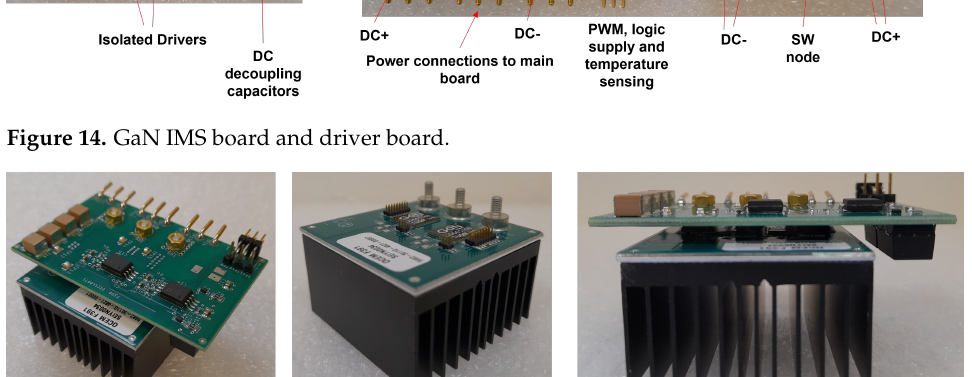
Figure 15. GaN daughter module assembly: driver board + IMS board + heat